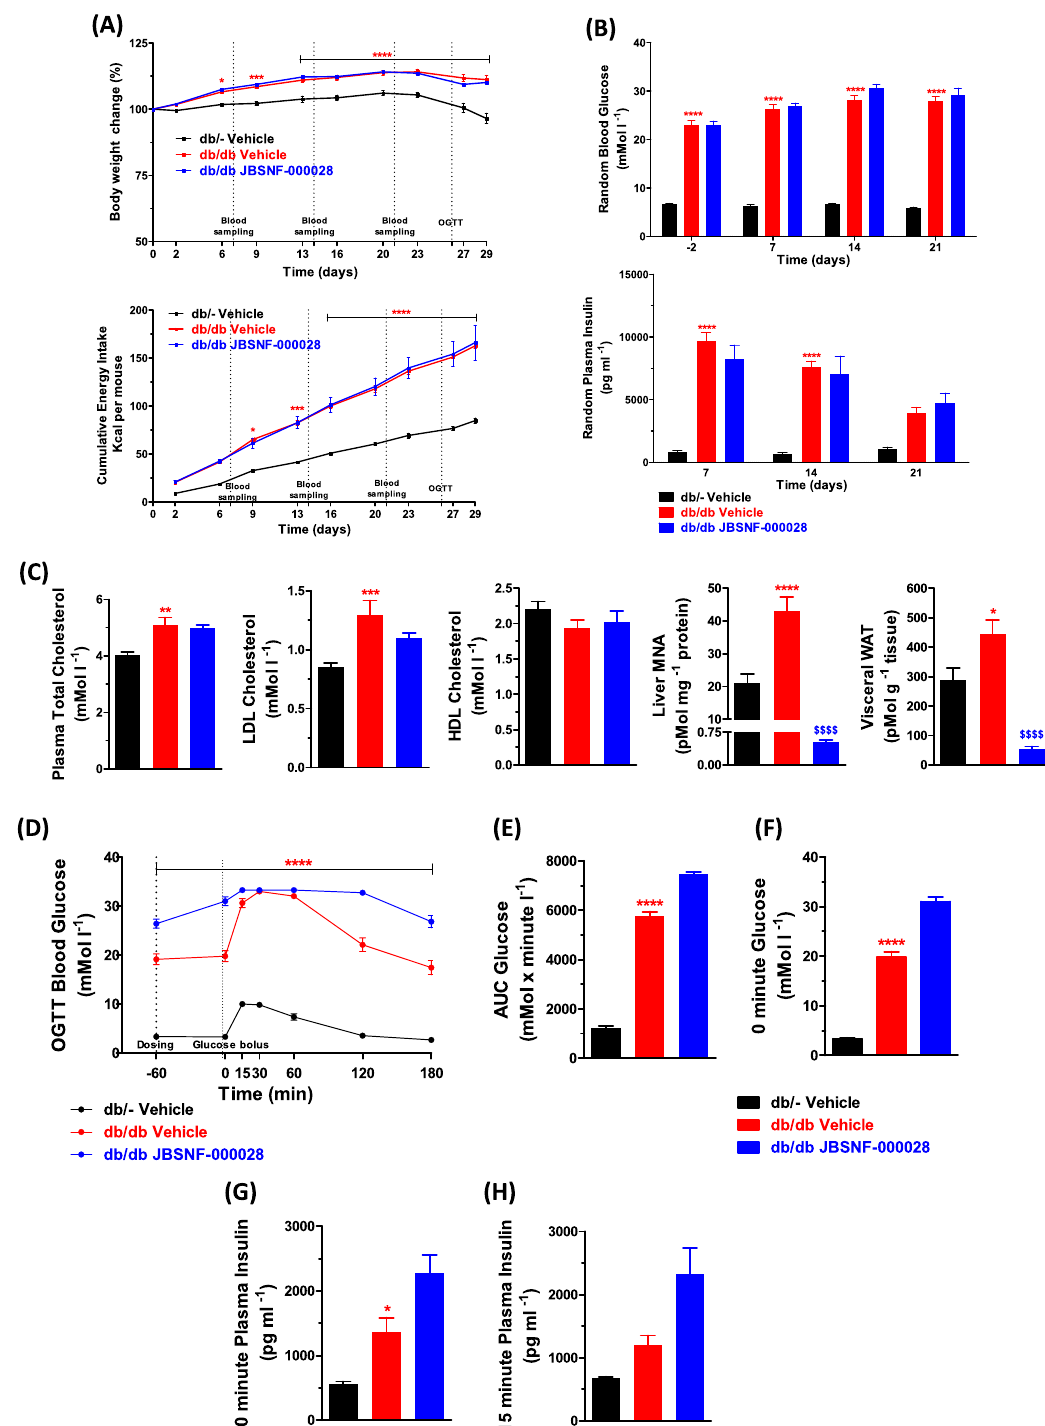
Figure 6. Efficacy of JBSNF-000028 in genetic model of type-2 diabetes (db/db mice). ( A ) Body weight changes (%) and cumulative energy intake in db/– control animals and db/db animals treated with vehicle or JBSNF-000028 at 50 mg kg −1 . ( B ) Fed blood glucose and fed plasma insulin profile of db/– control animals and db/db animals treated with vehicle or JBSNF-000028 at 50 mg kg −1 . (C) Plasma total cholesterol, plasma LDL cholesterol, plasma HDL cholesterol, MNA measurements in liver and visceral WAT samples of db/– control animals and db/db animals treated with vehicle or JBSNF-000028 at 50 mg kg −1 . (D) OGTT profile, ( E ) Area under the curve (AUC), ( F ) plasma glucose and ( G ) plasma insulin levels at the time of the glucose bolus. ( H ) Plasma insulin levels at t = 15 min after the glucose bolus in the OGTT. Data are presented as mean ± s.e.m. * p < 0.05, ** p < 0.01, *** p < 0.001 and **** p < 0.0001 when compared with db/– control and $$$$ p < 0.0001 when compared with db/db vehicle control. Two way ANOVA followed by Bonferroni’s post-hoc test ( A , B , D ); One way ANOVA followed by Bonferroni’s post-hoc test ( C , E – H